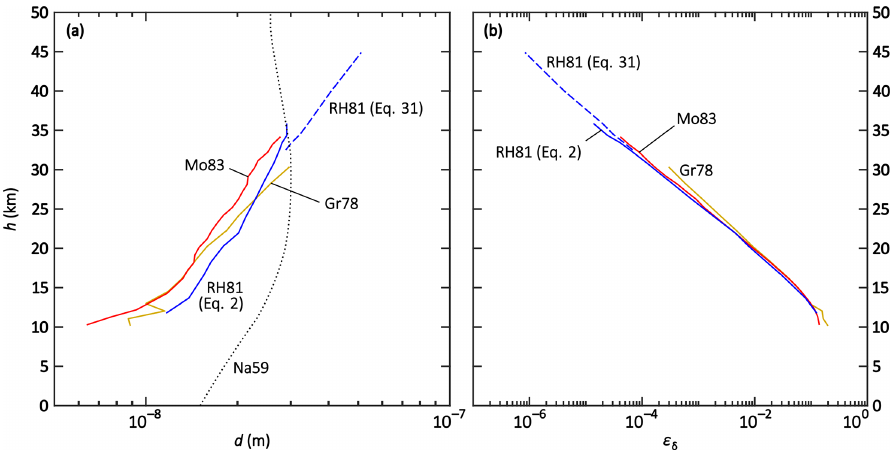
Figure 4. Altitude plots of the (a) numerically determined ion–ion trapping radius d and (b) analytically determined limiting sphere collision probability ε δ , each for the field data sets of Gringel et al. (1978) (Gr78, yellow), Rosen and Hofmann (1981) (RH81, blue), and Morita (1983) (Mo83, red). Additionally, the dotted curve (Na59) in panel (a) shows d N after Eq. (17) (Natanson,